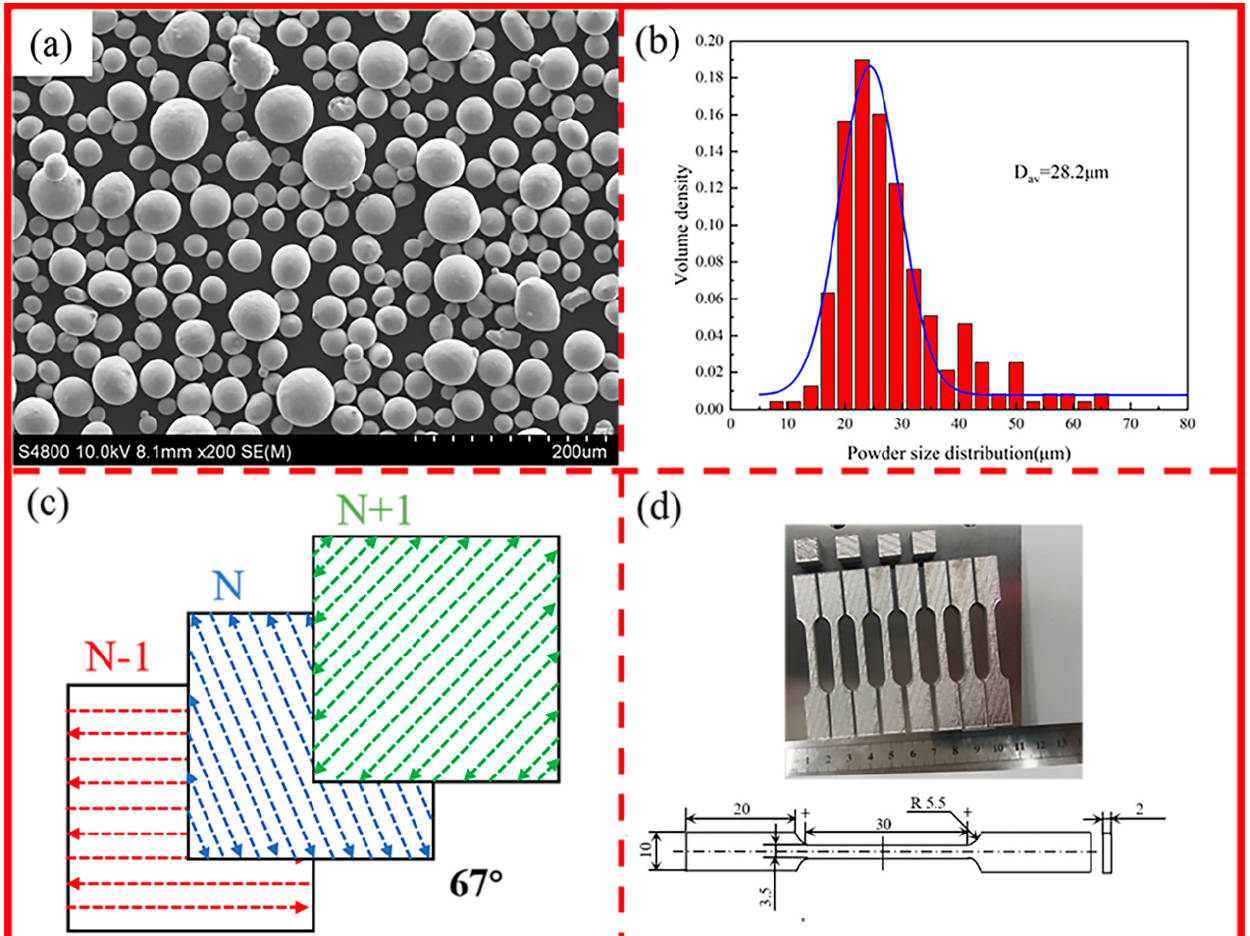
Figure 1. ( a ) Powder morphology of Ti-22Al-25Nb alloy, ( b ) particle size distribution of Ti-22Al-25Nb alloy, ( c ) schematic diagram of scanning strategies, ( d ) schematic of cubic and tensile specimens.